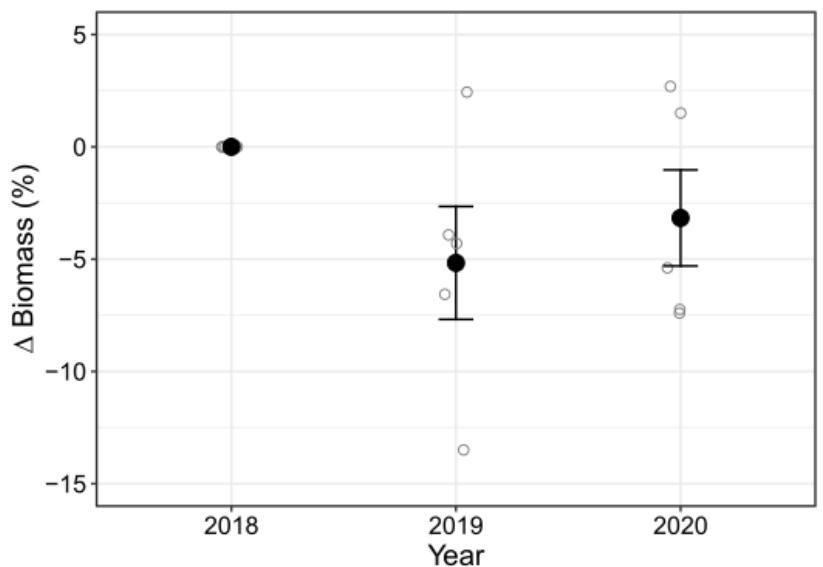
Figure 7. Percent change in the total algal biomass over two years, each time sampled in early January, one year after the manual removal of algae. Initial, pre-cleared 2018 biomass values ranged from 8.2 to 13.1 kg. Error bars span the 95% confidence interval around the mean (black circles) of the five experimental ice pits (open circles).